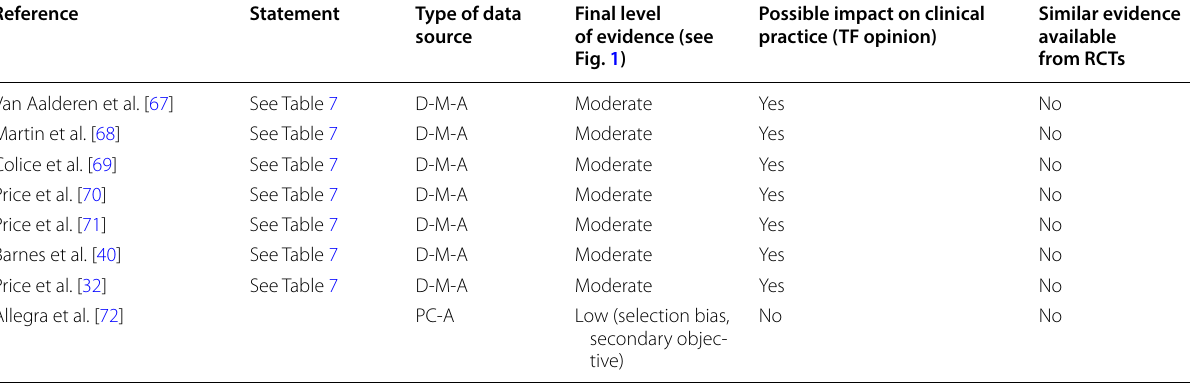
Table 6 Summary table of literature analysis, PICOT question 4: influence of ICS particle size on asthma